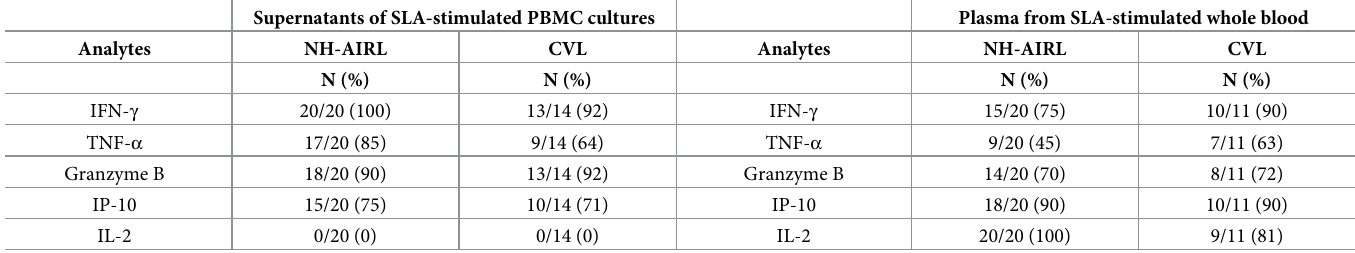
Table 2. Proportion of patients that produced cytokine levels above the calculated optimal cut-off values after SLA-stimulation of a whole blood sample. NH-AIRL asymptomatic immune responders to Leishmania , CVL patients cured of leishmaniasis. Supernatants of SLA-stimulated PBMC